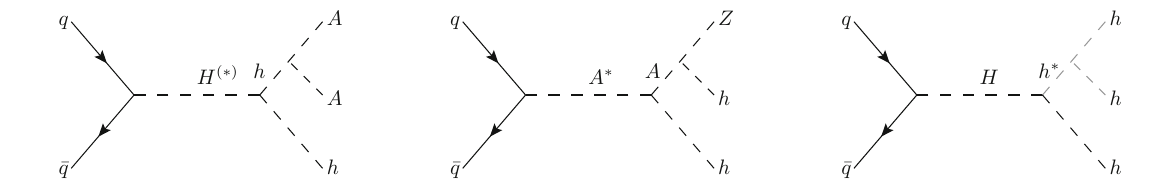
ilyoff-shell.Thusthecorrespondingcrosssectionscannotbecalculated as σ( gg / b ¯ b / q ¯ q ( (cid:2) ) → h i h x ) ∗ BR ( h x → h j + h k / V k ) . Such 3BFSs have therefore been typeset in grey colour in Table 4